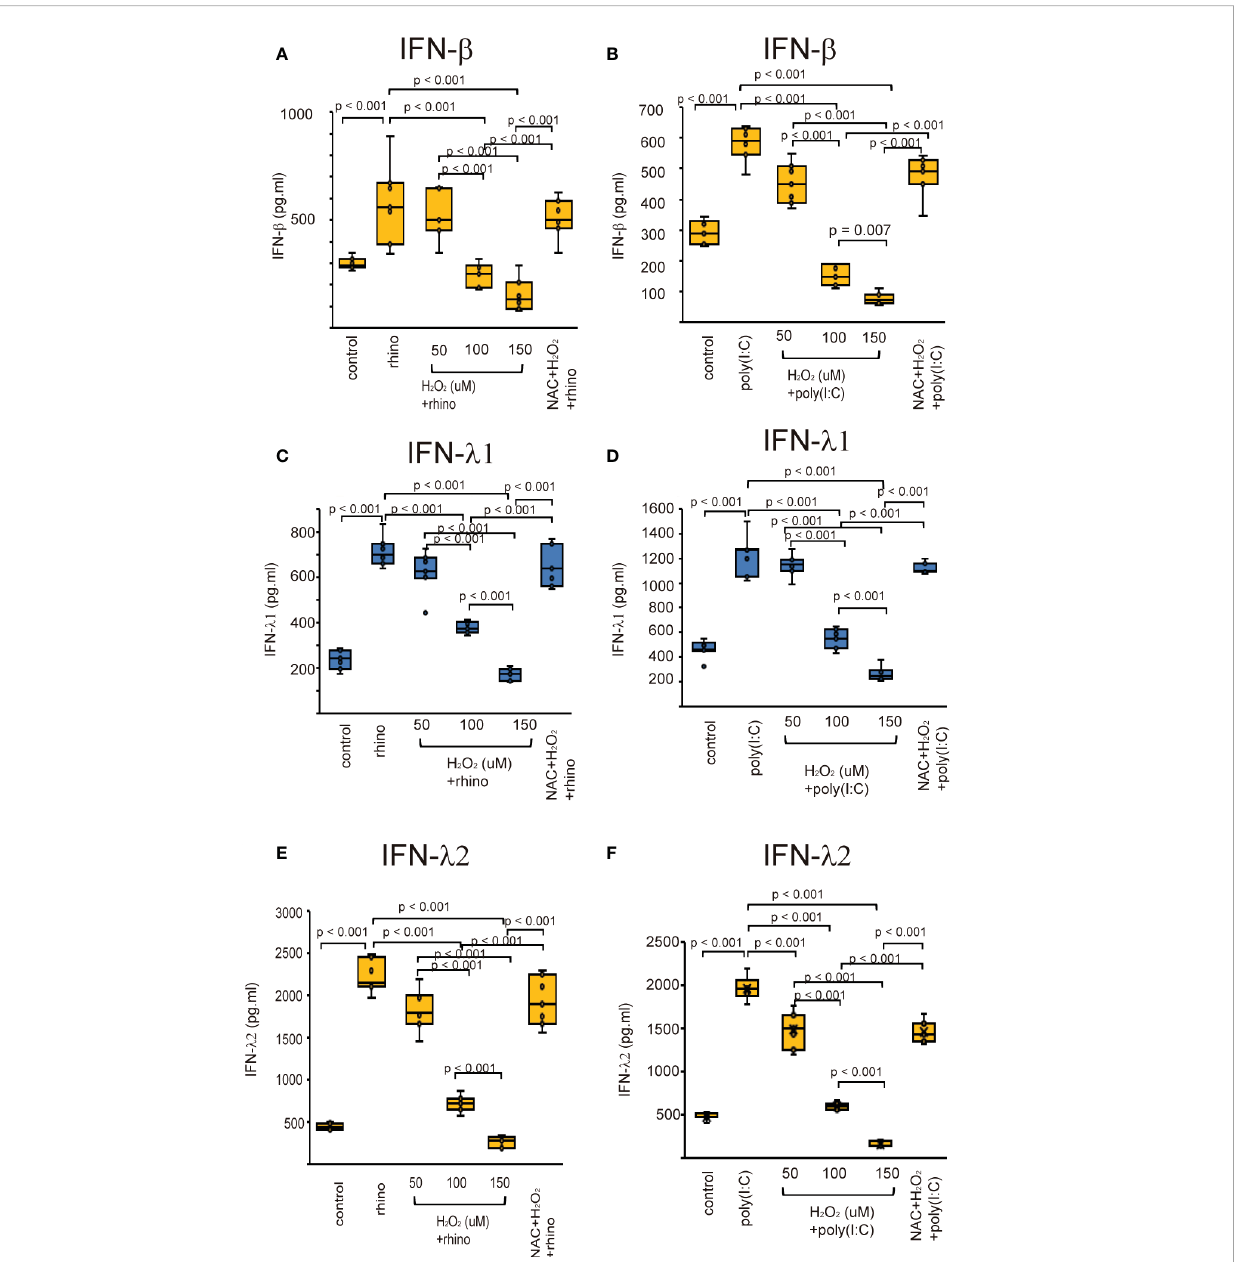
FIGURE 3 The concentration of IFN- b (A, B) , IFN- l 1 (C, D) , and IFN- l 2 (E, F) in basal media of cultured cells pretreated with H 2 O 2 at 50, 100, and 150 uM and then, followed by RV 16 infection (A, C, E) or poly (I: C) treatment (B, D, F) which were evaluated with ELISA. Data are mean ± SEM from 7 different epithelial donors. Control indicates non-treated normal epithelial cells. Rhino indicates epithelial cells infected with RV 16. H 2 O 2 + rhino indicates the epithelial cells pretreated with H 2 O 2 at 50, 100, and 150 uM followed by RV 16 infection. NAC+ H 2 O 2 +rhino indicates the cells which were pretreated with NAC at 5 mM for 1 h and then followed by H 2 O 2 treatment at 100 uM and subsequently infected with RV 16. Poly (I: C) indicates epithelial cells treated with poly (I: C). H 2 O 2 + poly (I: C) indicates the epithelial cells pretreated with H 2 O 2 at 50, 100, and 150 uM followed by poly (I: C) treatment. NAC+ H 2 O 2 + poly (I: C) indicates the cells which was pretreated with NAC at 5 mM for 1 h and then followed by H 2 O 2 treatment at 100 uM and subsequently treated with poly (I: